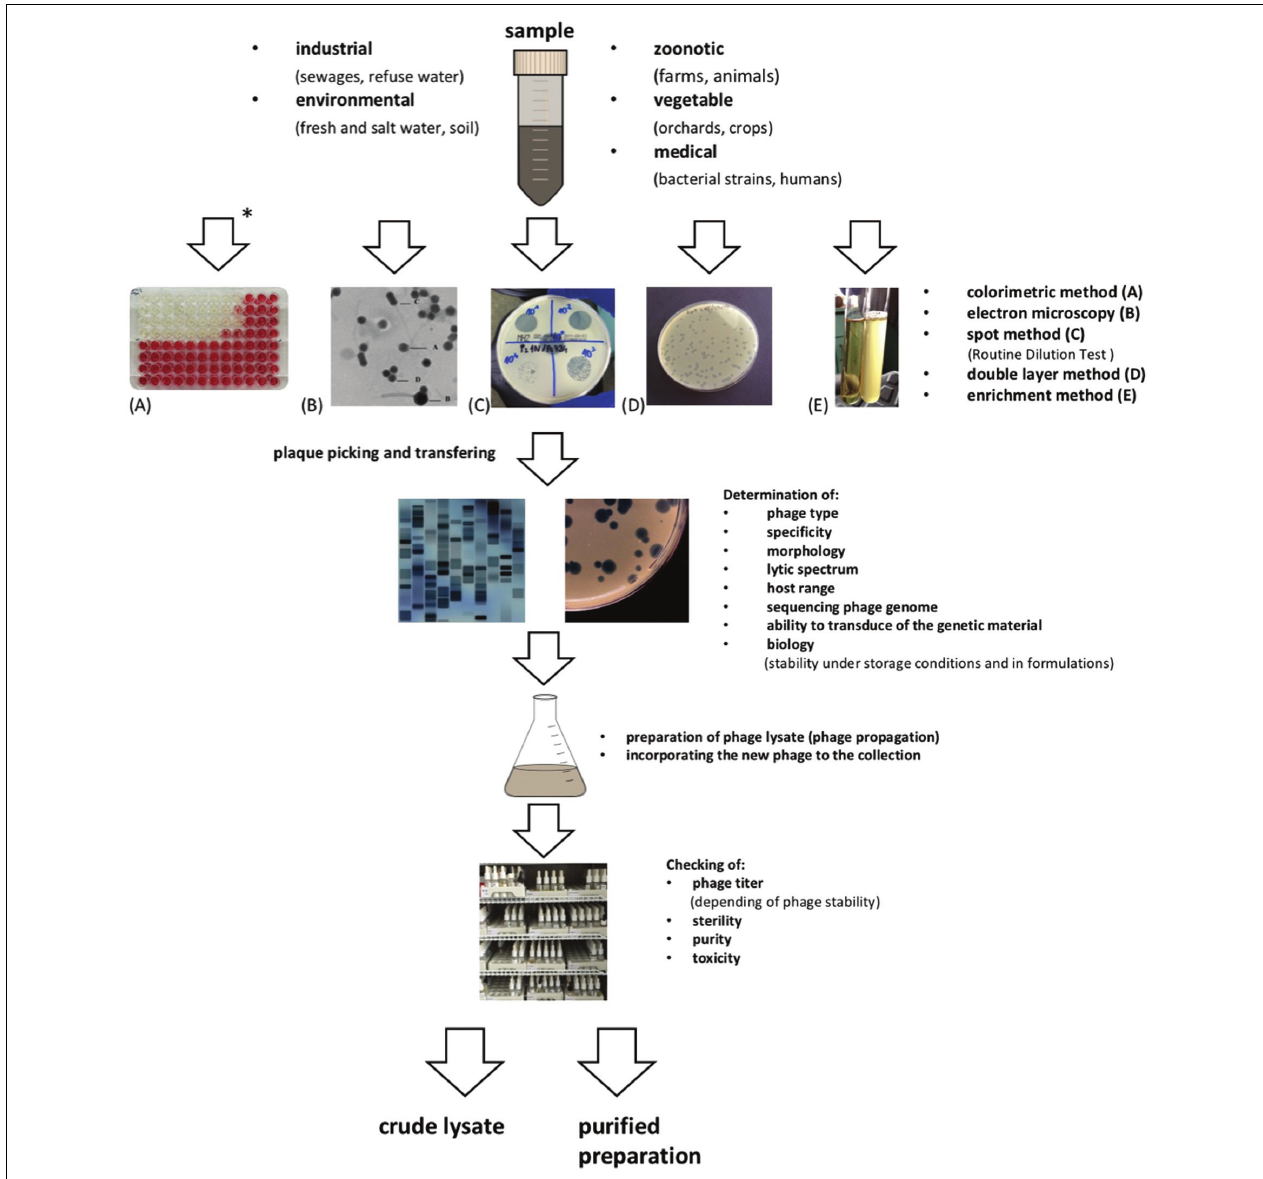
FIGURE 1 | Steps in phage isolation for therapeutic